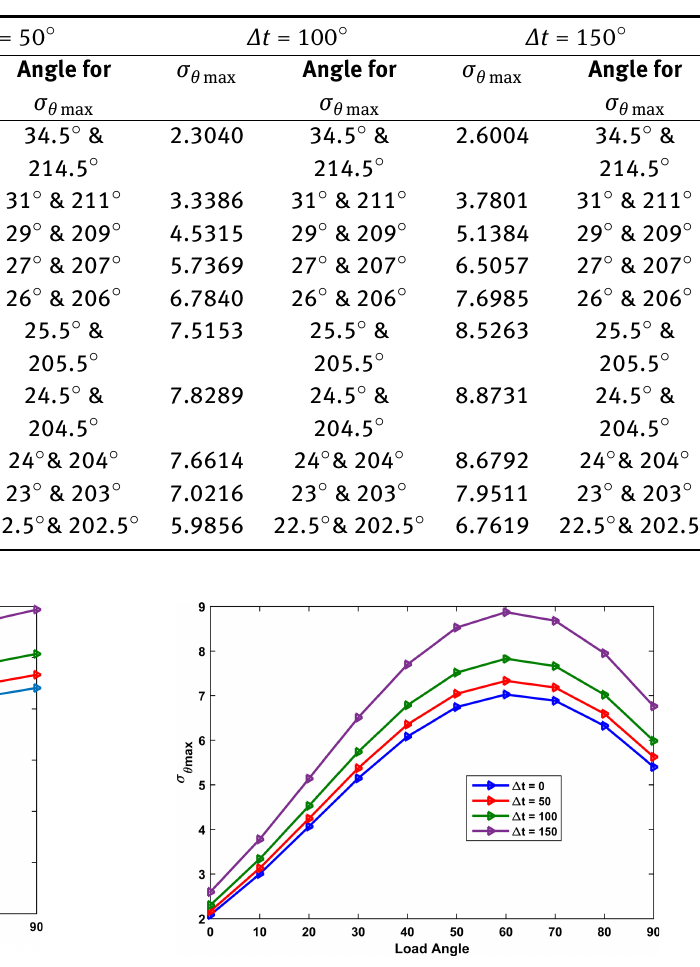
Table 4: Effect of ∆t and load angle on σ θmax (a/b = 2, Load angle variation from 0 ∘ to 90 ∘ axis, [45/ − 45]s)